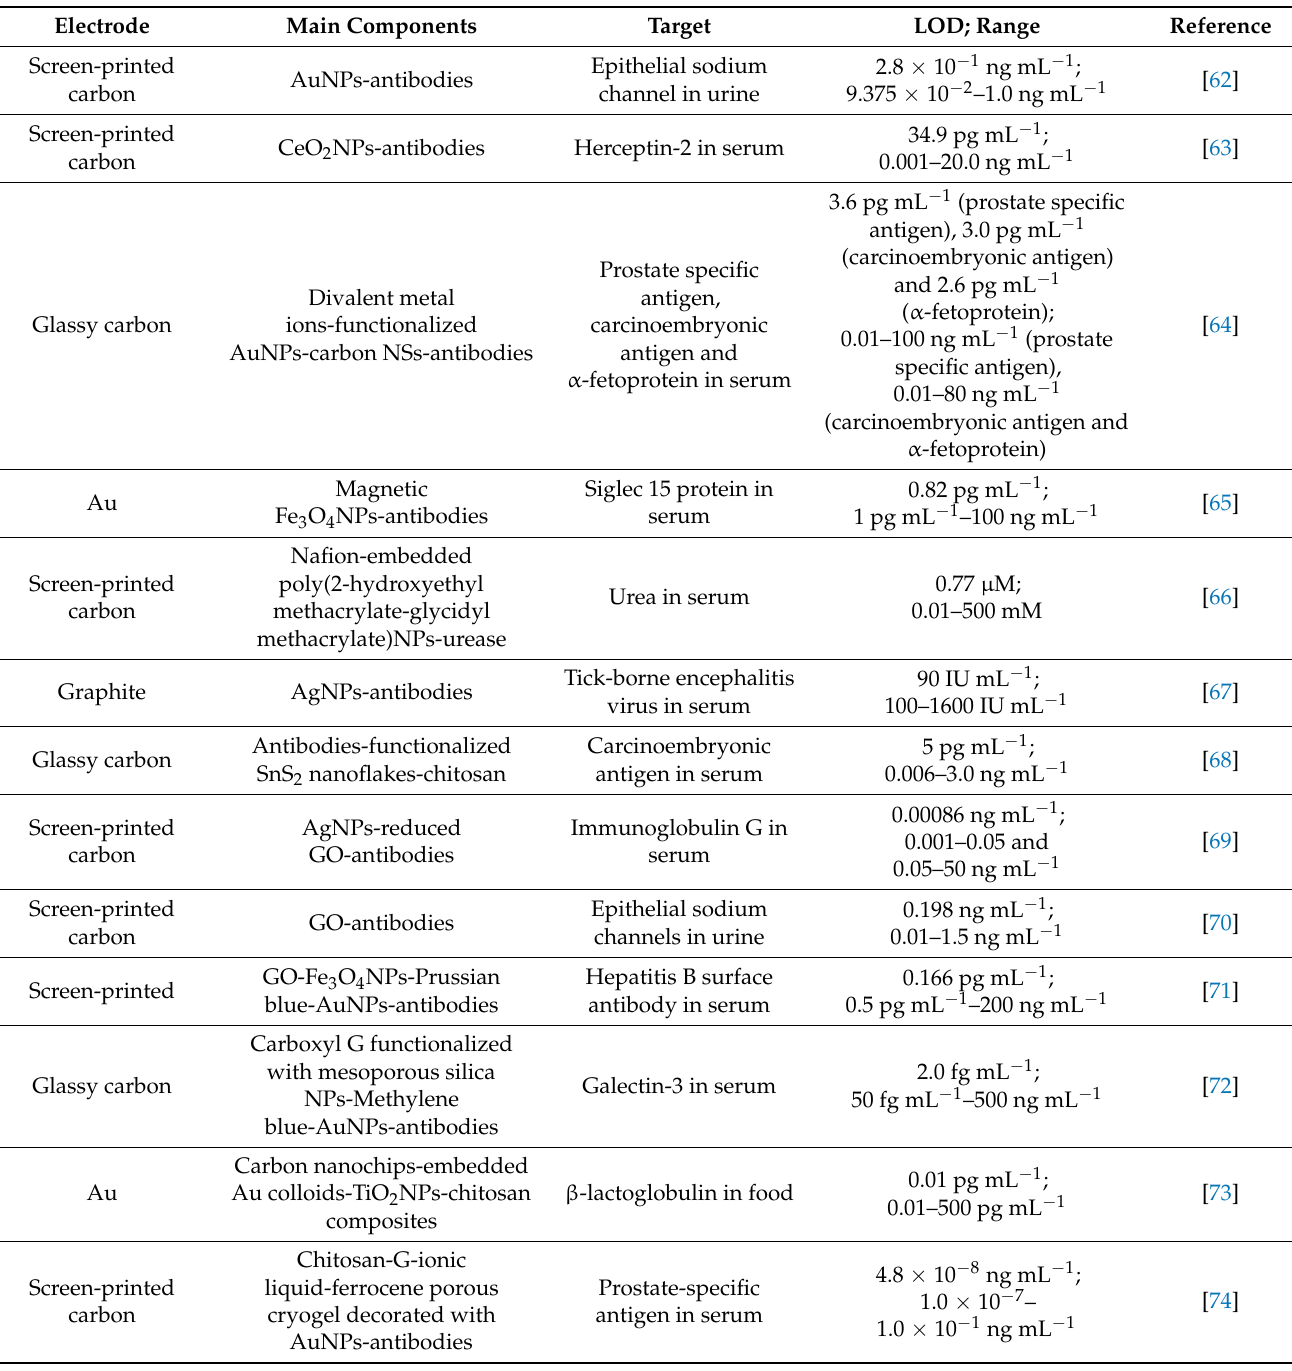
Table 2. Electrochemical immunosensors cited in this